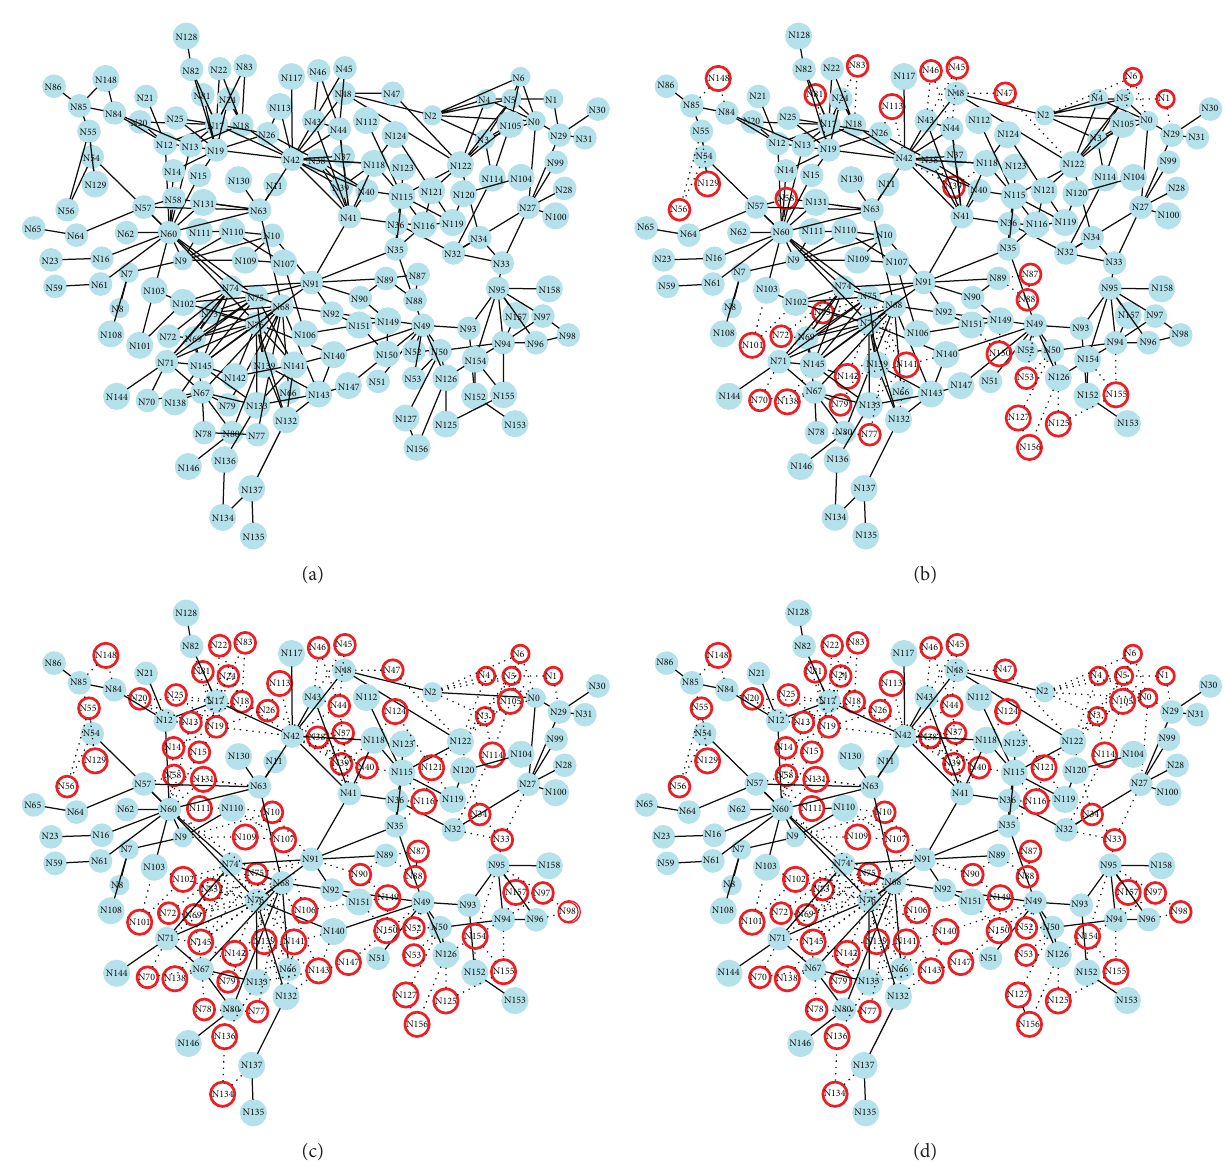
Figure 9: EBONE Network Topology (a); virtual router migration and switching off of physical nodes when 𝛾 = 0% (b), 𝛾 = 60% (c) and 𝛾 = 80% (d),